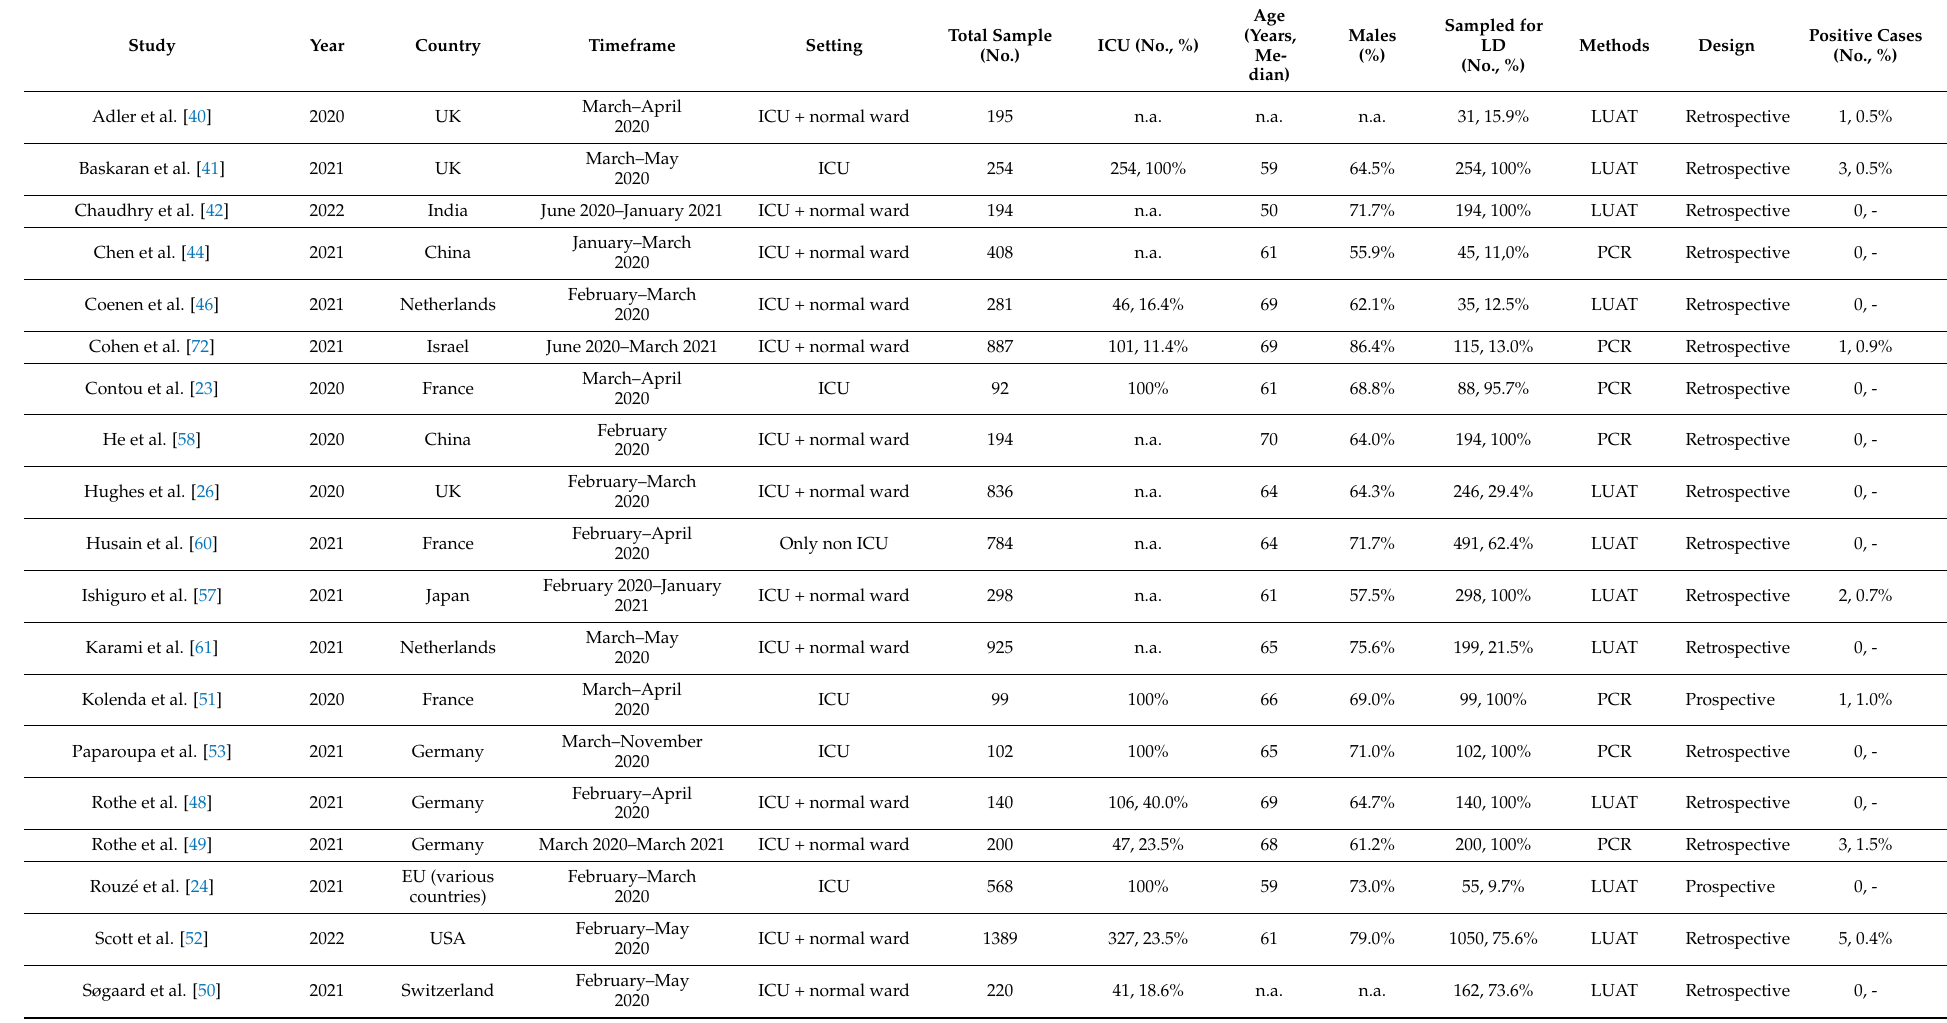
Table 1. Summary of the case-control studies, cross-sectional studies, and cohort studies included in the meta-analysis. Notes: EU = European union, LD = Legionnaires’ disease; ICU = intensive care unit; LUAT = Legionella urinary antigen test; PCR = polymerase chain reaction; n.a. not